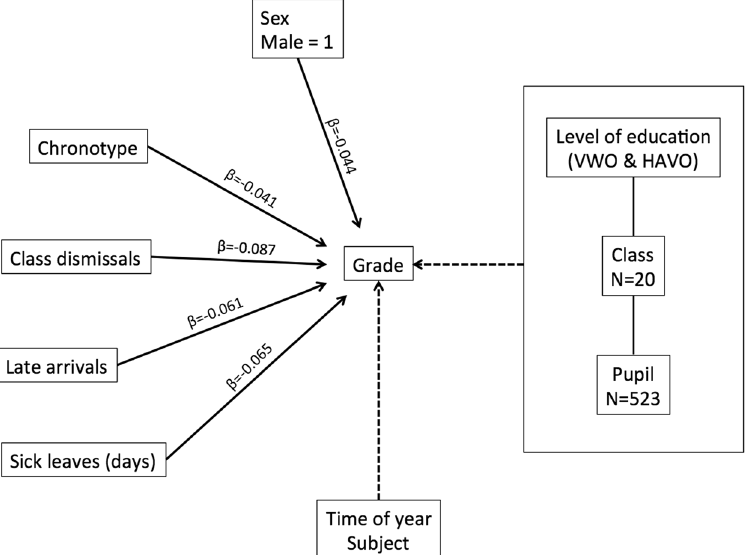
Figure 1. Multilevel model selected as the most parsimonious fit (according to the AIC) to explain the influence of the independent variables on school grades (dependent variable). The explanatory (independent) variables were: sex, chronotype (MSF sc ), late arrivals during the first hour, class dismissals, and sick leaves (duration). The standardised beta coefficients ( β ) were negative for each variable and are reported on the solid connecting lines between independent and dependent variables. The interpretation of a negative beta coefficient is the following: for every 1-standard deviation increase in the explanatory variable, the standard deviation of the dependent variable will decrease by the beta coefficient value. For the variable ‘sex’, males were compared with females, meaning that a negative beta coefficient reflected a decrease in grades for males. Time of year and school subject were evaluated in the model as covariates (dashed connecting